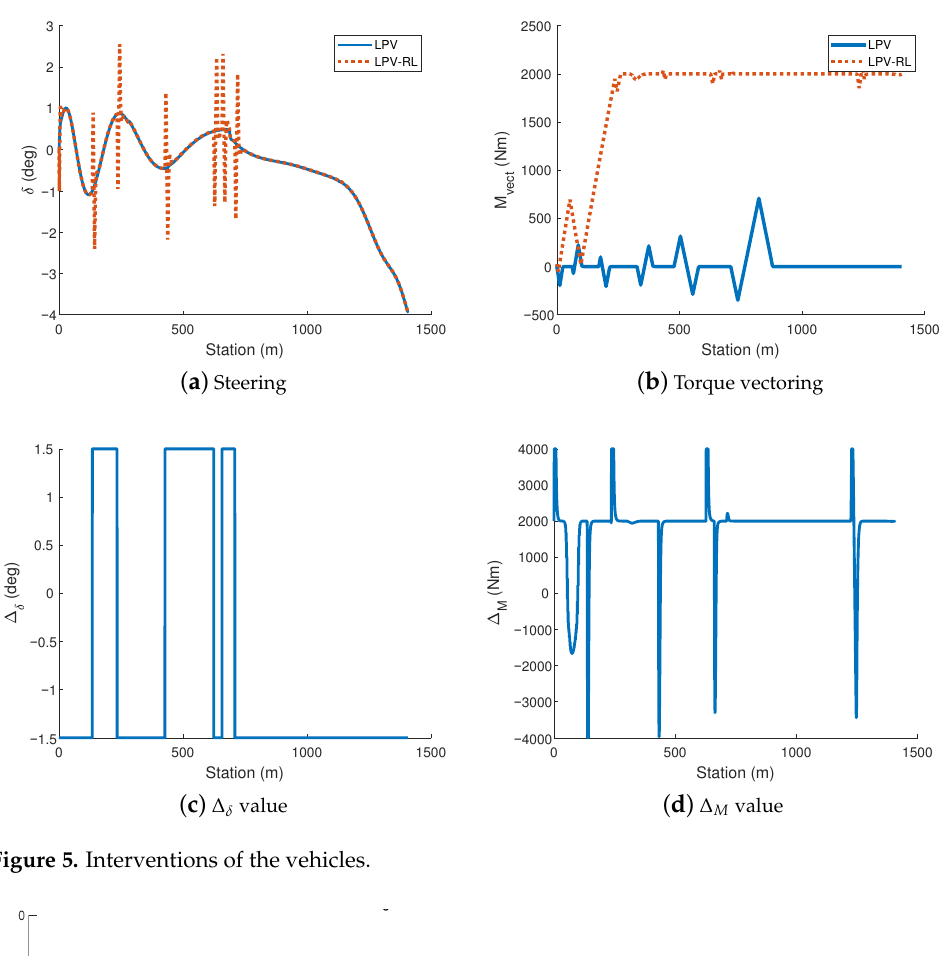
Figure 5. Interventions of the vehicles.